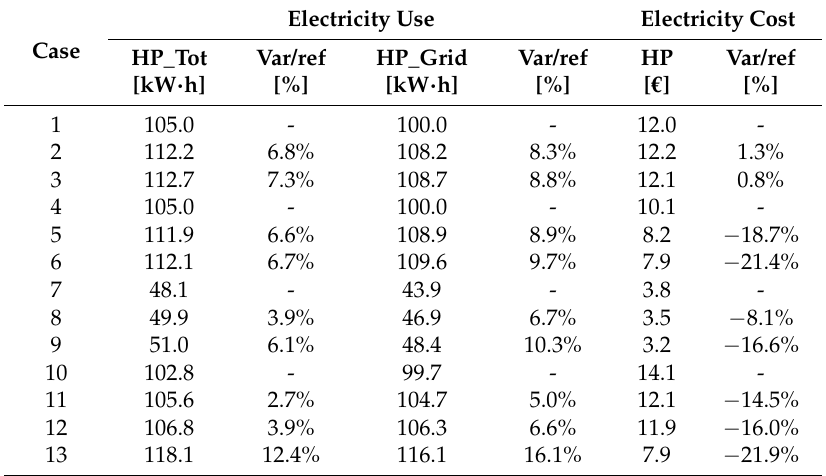
Table 5. Results of the different cases in terms of electricity use and corresponding costs. HP_Tot corresponds to the total heat pump electricity consumption (DHW and space heating), and HP_Grid is calculated removing the PV production when available (hence it represents the electricity that the user needs to purchase from the grid to operate the heat pump). The percentages of variations are calculated with regards to the reference cases 1, 4, 7, and 10 (for Case 13, Case 4 is used as a reference). Electricity Use Electricity Case